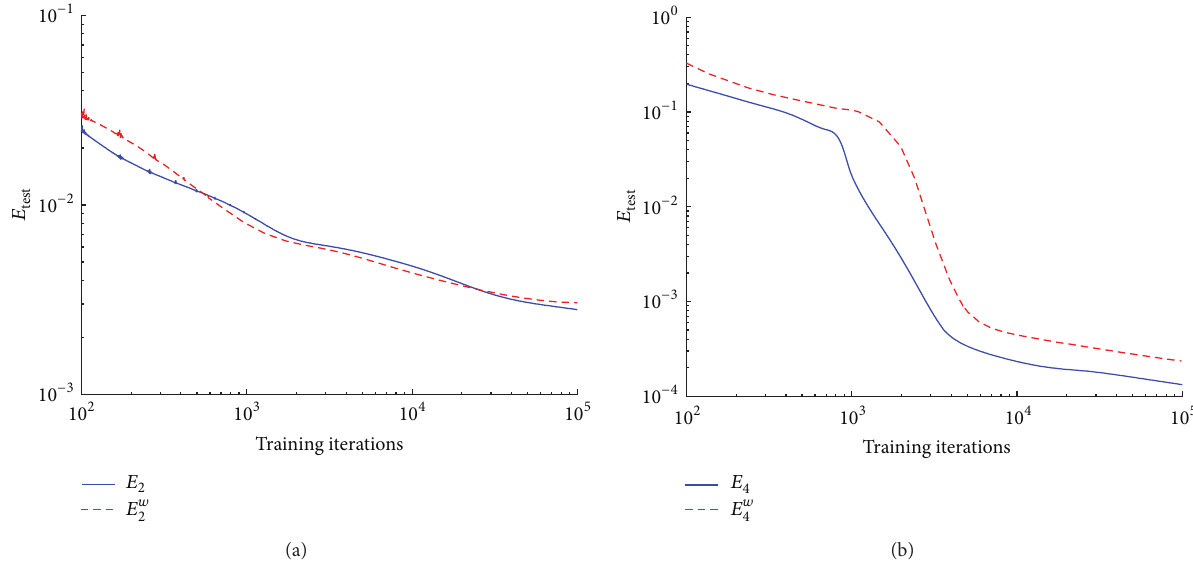
Figure 10: Validation error during training. (a) Error functions with 𝑅 = 2 ; 𝐸 2 , 𝐸 𝑤 2 . (b) Error functions with 𝑅 = 4 ; 𝐸 4 , 𝐸 𝑤 4